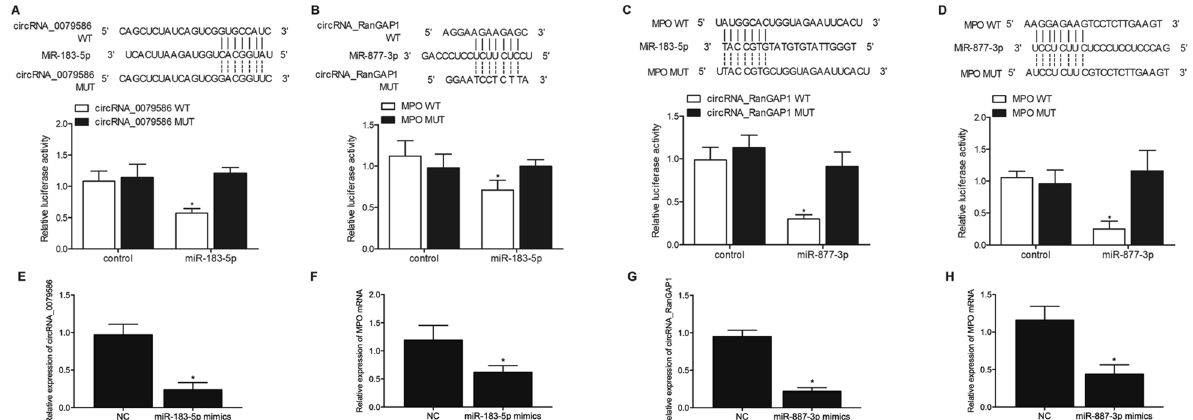
Figure 2. Luciferase assays revealed the regulatory relationships of circRNA_0079586/miR-183-5p, circRNA_ RanGAP1/miR-877-3p, miR-183-5p/MPO, and miR-877-3p/MPO. ( A ) Sequence analysis and luciferase assay indicated that miR-183-5p could inhibit the expression of circRNA-0079586 (* P < 0.05 vs. circRNA_0079586 MUT). ( B ) Sequence analysis and luciferase assay indicated that miR-877-3p could inhibit the expression of circRNA-RanGAP1 (* P < 0.05 vs. MPO MUT). ( C ) Sequence analysis and luciferase assay indicated that miR- 183-5p could inhibit the expression of MPO (* P < 0.05 vs. circRNA_RanGAP1 MUT). ( D ) Sequence